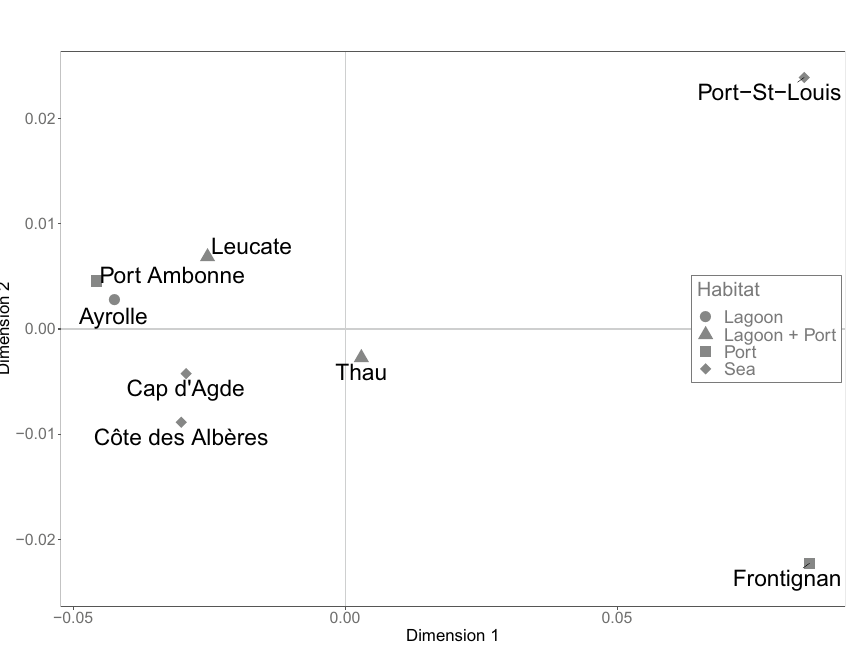
Table 3. F ST values of pairwise comparisons (Robertson and Hill estimator for F ST , 1984 corrected by Raufaste & Bonhomme, 2000) between the 8 localities where Pinna nobilis specimens were collected. *Indicates significant values after Bonferroni sequential correction.